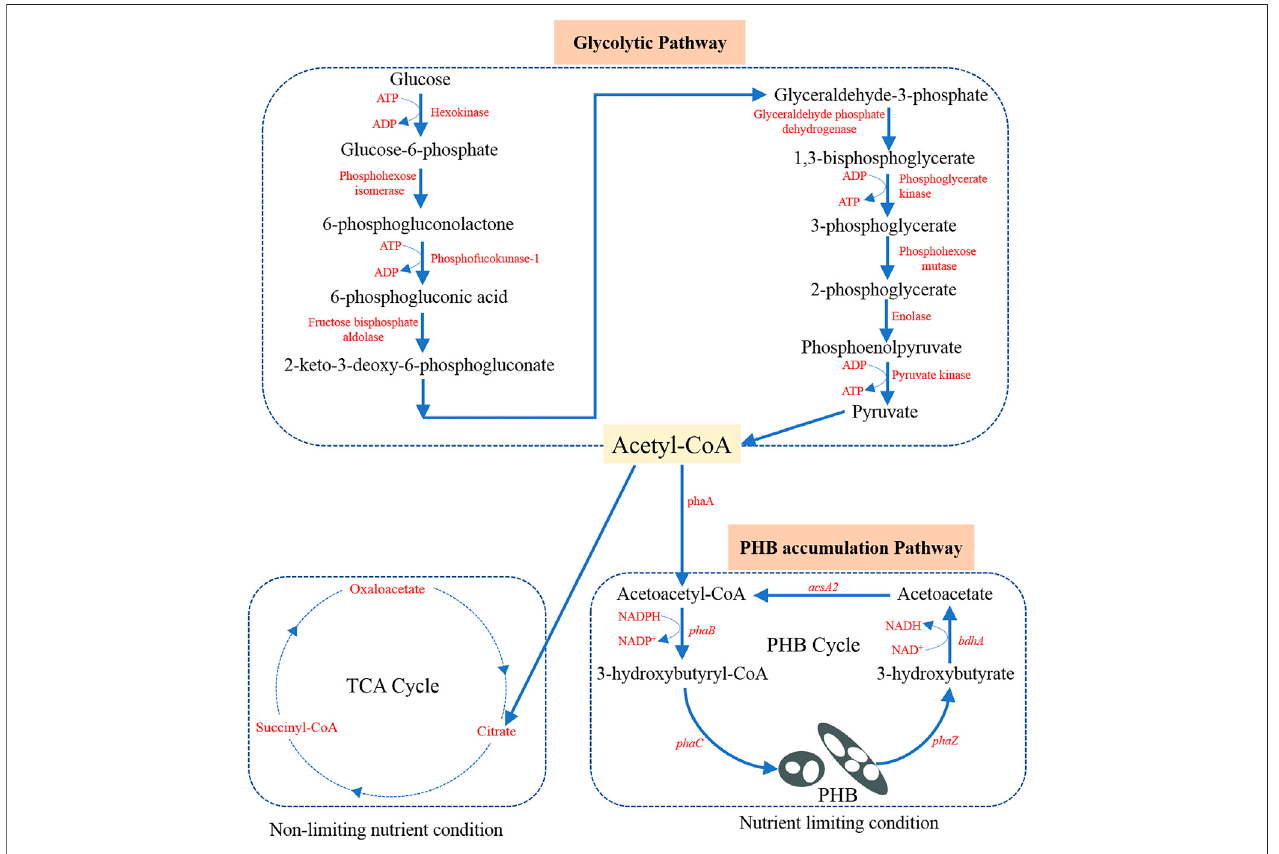
FIGURE 1 | Potential metabolic pathway in C. necator from glucose to acetyl-CoA precursor and further to PHB. Adaption from Karthikeyan et al. (2015).